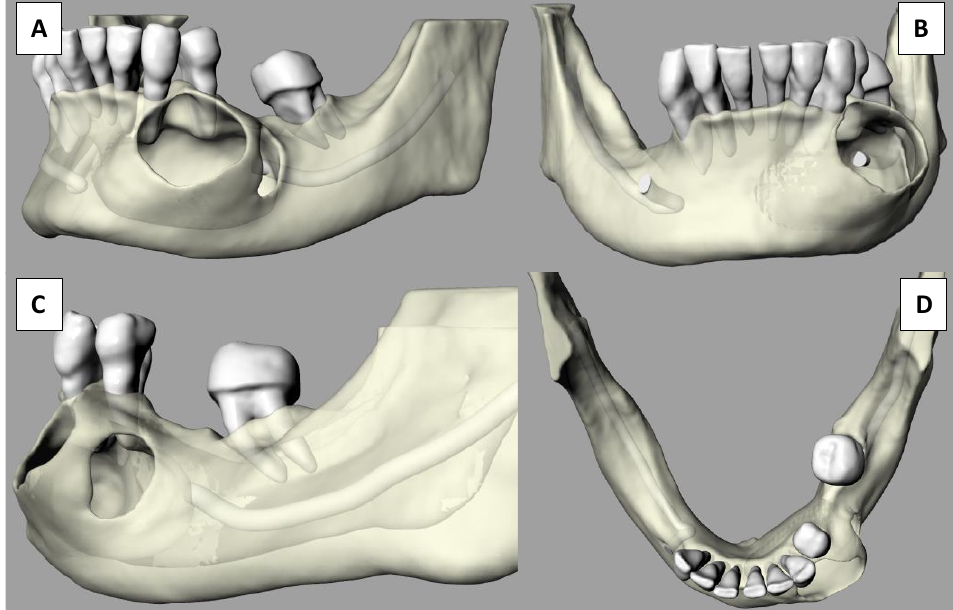
Figure 4. 3D mandibular representation. ( A ) Left hemimandibular aspect. ( B ) Frontal aspect. ( C ) Lateral aspect. ( D ) Vertical aspect.